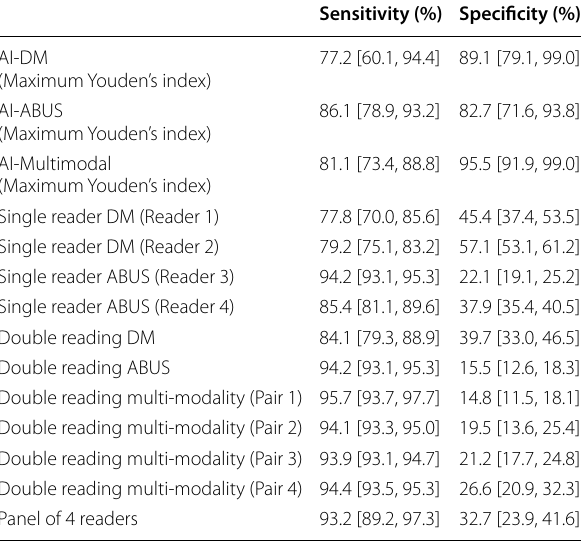
Sensitivity and Specificity (including 95% confidence intervals) values of radiologists and artificial intelligence (AI) systems in digital mammography (DM), automated 3D breast ultrasound (ABUS), and the multi-modality simulation for the observer study cohort